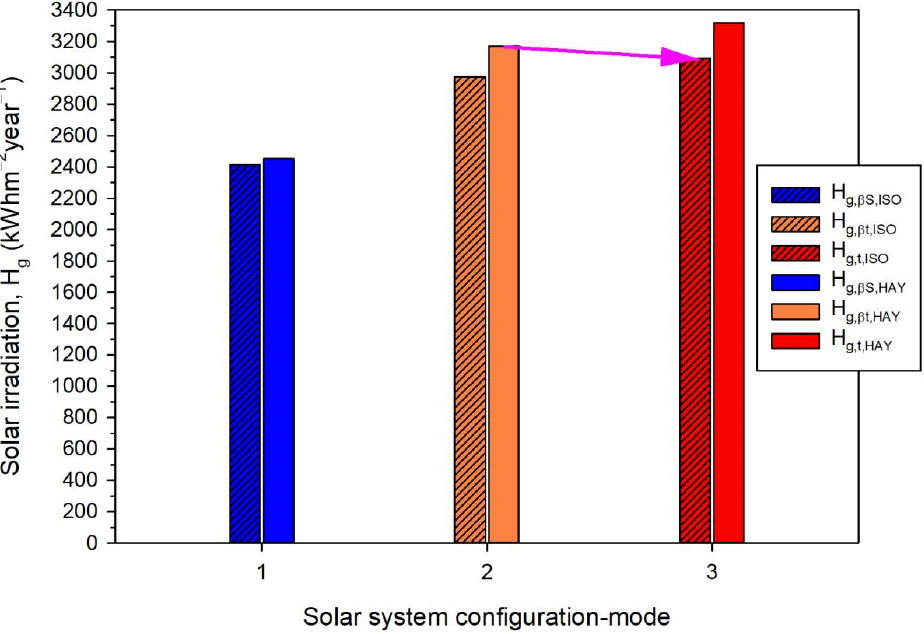
Figure 4. Annual solar energy yields averaged over the 82 sites in Saudi Arabia and the period 2005–2016 under all-sky conditions. The variations are shown for the 3 solar system configuration-modes and both ISO- and HAY-modelled results. The numbers 1, 2, and 3 on the x-axis represent the configuration modes-(i), -(ii), and -(iii), respectively. The pink arrow shows the lower solar energy in the configuration-(iii) ISO case compared to the configuration-(ii) HAY